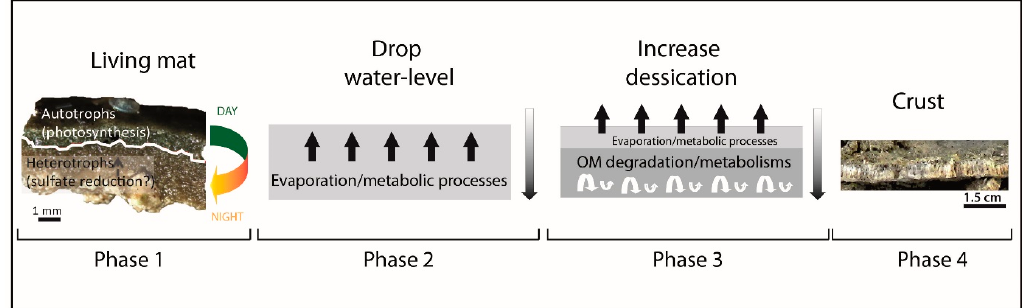
Figure 8. Proposed model of formation for the dry crust. Phase 1: Living mats are not fully layered but composed of several microorganisms, including cyanobacteria and heterotrophic microorganisms (Pacton et al., [35]). Photosynthesis is dominant during the day, whereas heterotrophic organisms, such as SRB, take over at night. Mineralization occurs mainly in the lower part of the mat and results most probably from OM degradation by heterotrophic activity [35]. Phase 2: A subsequent decrease in water level leads to evaporation, thus promoting calcium carbonate precipitation abiotically, which is further combined with carbonate produced as a result of microbial metabolic processes. Phase 3: The upper part of the mat / environment interface would eventually be completely mineralized, forming an isolating layer, thus promoting OM degradation in the lower part. Phase 4: The final product is a fully